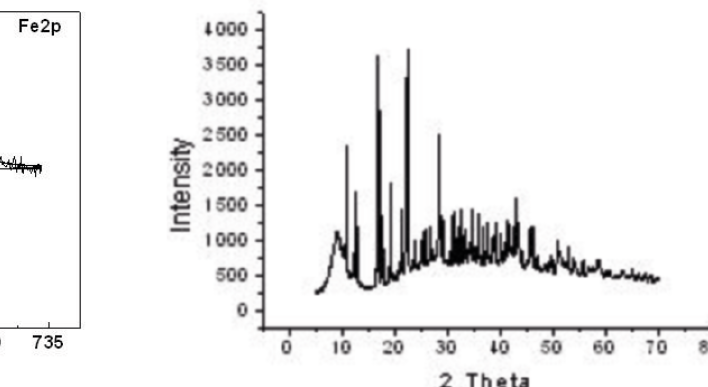
Figure 9. XPS spectrum from the Fe2p level of sample “Precursor”. Figure 10. XRD patterns of the sample